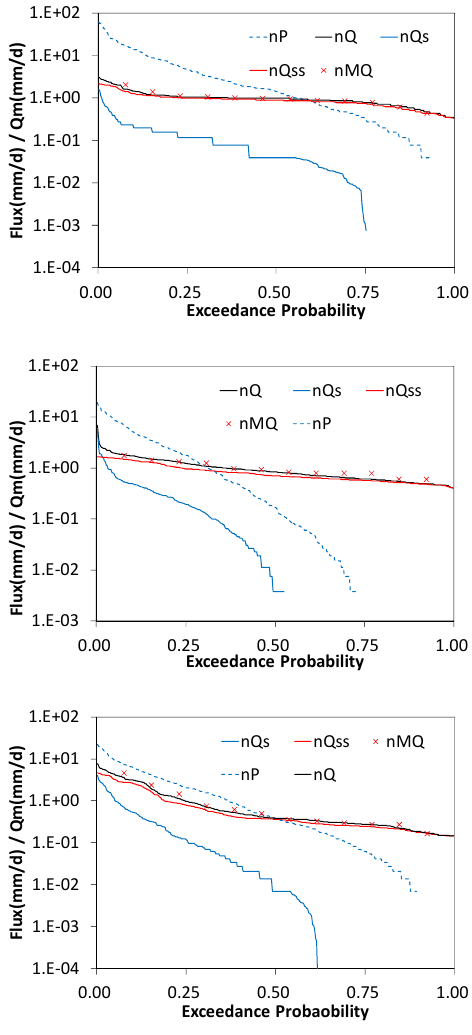
Fig. 9. Three example applications of the concepts derived from this paper: Relationships among duration curves of precipitation ( nP ), total runoff ( nQ ), surface runoff ( nQ s ), subsurface runoff ( nQ ss ), all at daily time scales and normalized by annual mean daily flow ( Q m ) along with mean monthly runoff ( nMQ ) at daily time scale normal- ized by annual mean daily flow ( Q m ). (a) data from MOPEX wa- tershed #86, Salmon River at Salmon, Idaho, (b) data from MOPEX watershed #237, Nantahala River near Rainbow Springs, North Car- olina, and (c) data from MOPEX watershed #323, Lochsa River near Lowell,